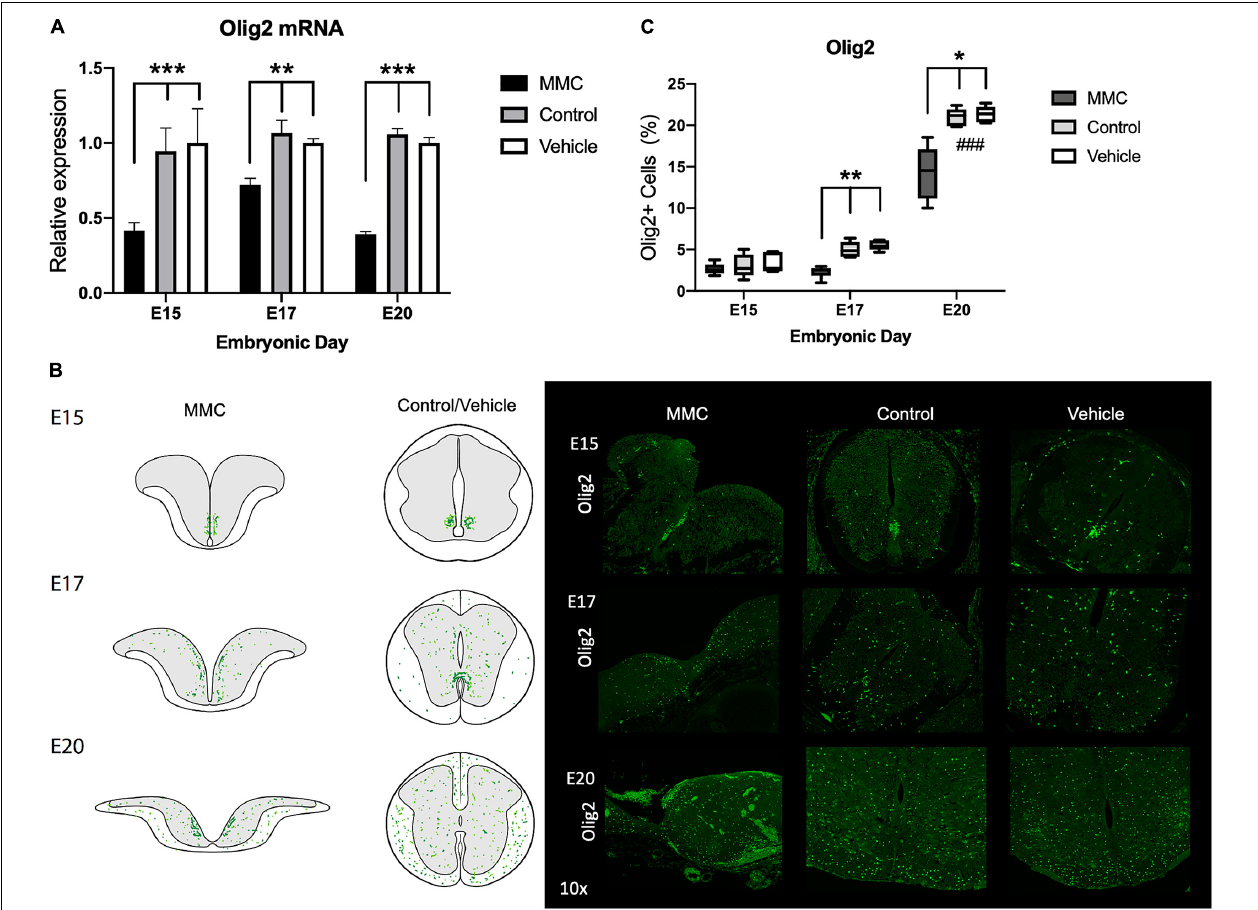
FIGURE 7 | Olig2 expression and distribution in spina bifida. (A) Olig2 relative expression increased in spina bifida (MMC) compared with control and vehicle spinal cords at E15 and E17. Values (means ± SE, 6 fetuses/group) of relative expression (2 – (cid:49)(cid:49) Ct ) for RA-treated and time-matched controls (* p < 0.05, ** p < 0.01, *** p < 0.001). (B) Schematic representation of Olig2 distribution in MMC and control spinal cords at E15, E17, and E20 (left). Olig2+ staining in MMC, control, and vehicle spinal cords at E15, E17, and E20 (right) (10 × ). Olig2 (green) immunoreactive NPC cells exposed at E15, E17, and clustering at E20 in spina bifida (10 × ). (C) % Olig2+ NPC in spina bifida (MMC), control, and vehicle fetal spinal cords determined by Olig2 stained cells/total cells at three gestational ages E15, E17, and E20 (means ± SD, * p < 0.05, ** p < 0.01, ### p < 0.001 between control and vehicle groups at E20 compared to E15 and E17).